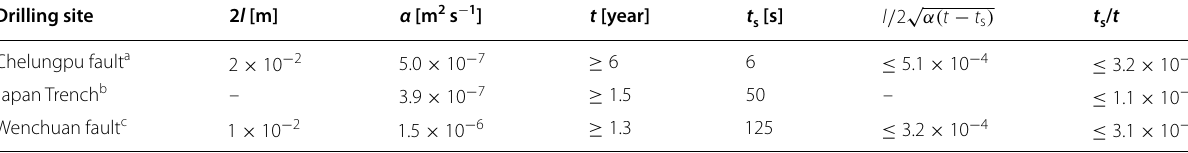
Table 2 Properties of the three fault zones where temperature observations were performed Drilling